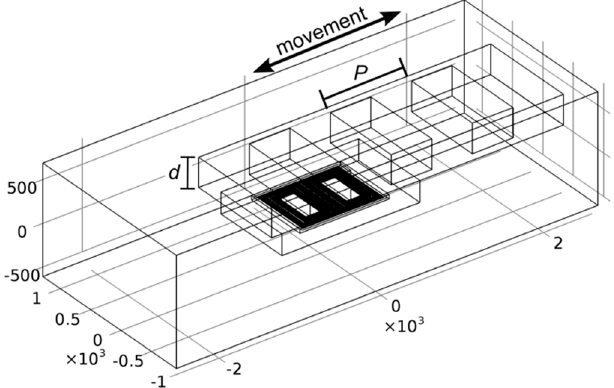
Figure 7. The simulated microtransformer pair geometry with a scale period P of 1 mm and a d = 0.35 mm thick target scale, representing the ferromagnetic scale type. The direction of the scale movement is indicated by an arrow. Dimensions are given in µm.